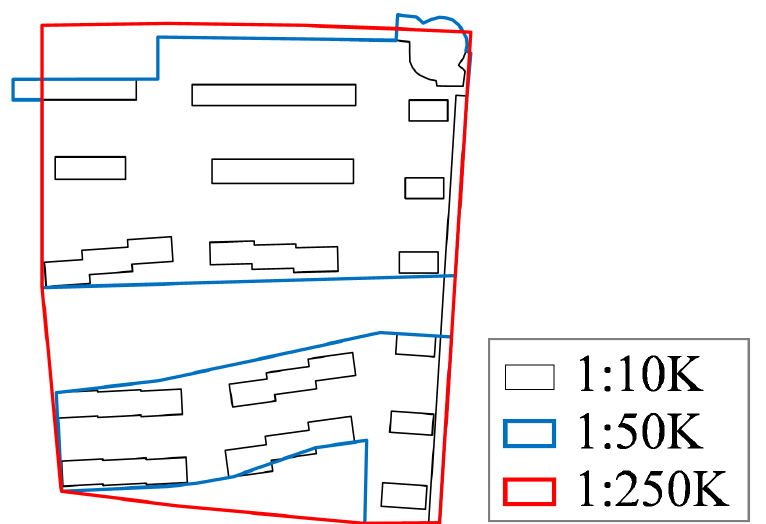
Figure 5. An example of a correspondence relationship between residential areas at different